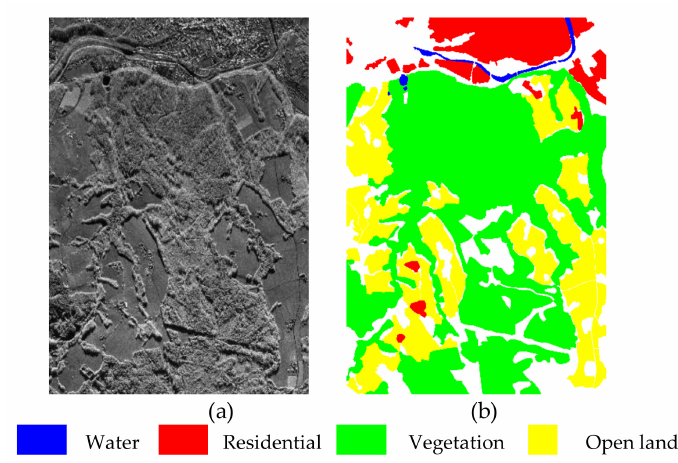
Figure 8. F-SAR image. ( a ) Original SAR image. ( b )